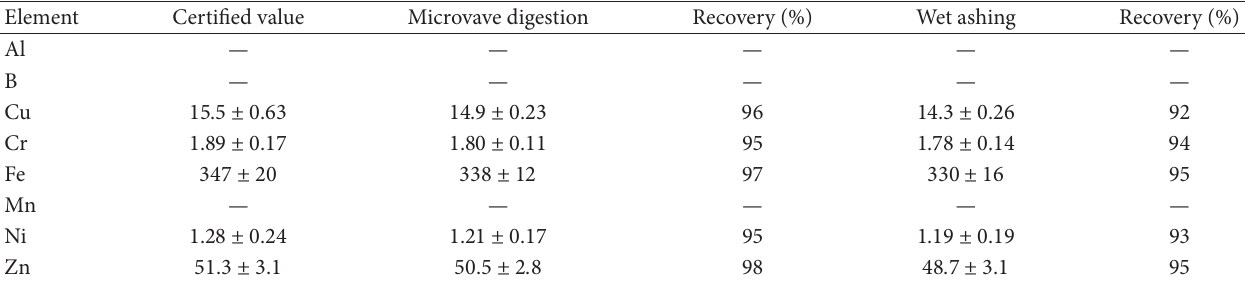
Table 2: Certified and observed values ( 𝜇 gg − 1 ) of trace elements in DORM-3, ( 𝑁 = 4 ). Element